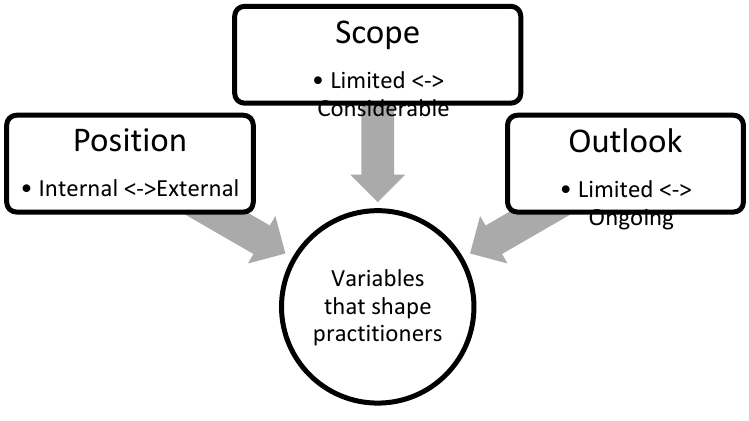
Figure 10 . Three variables that shape